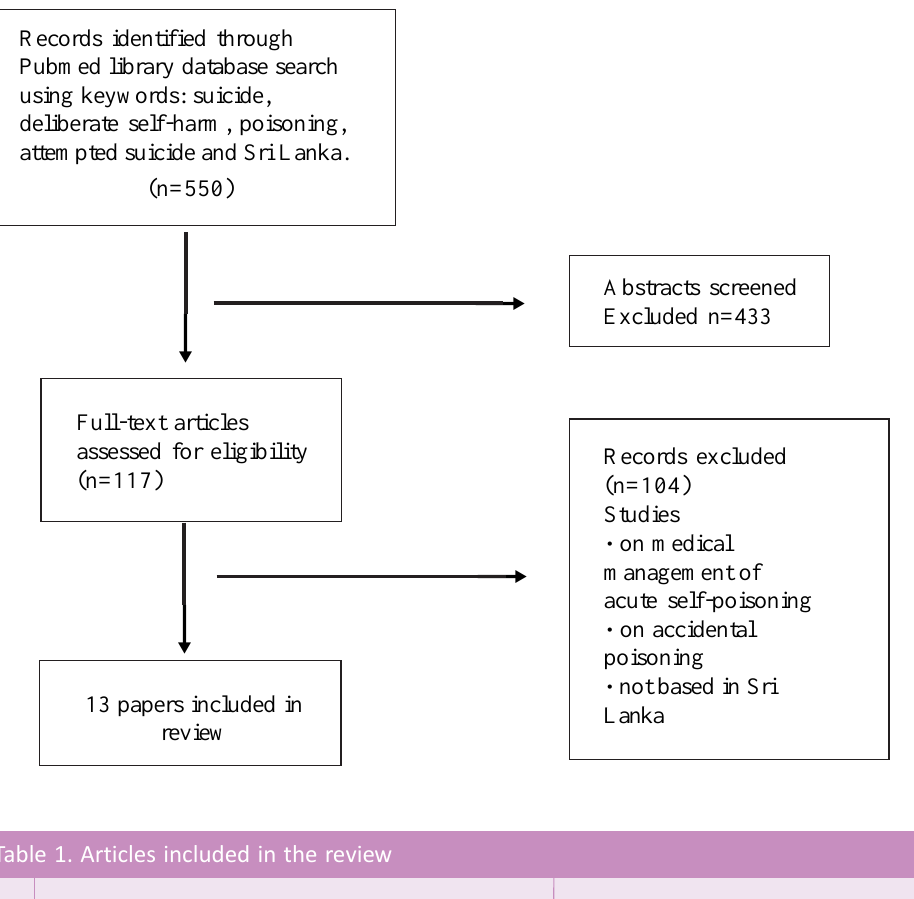
Figure 1. Flow diagram for literature